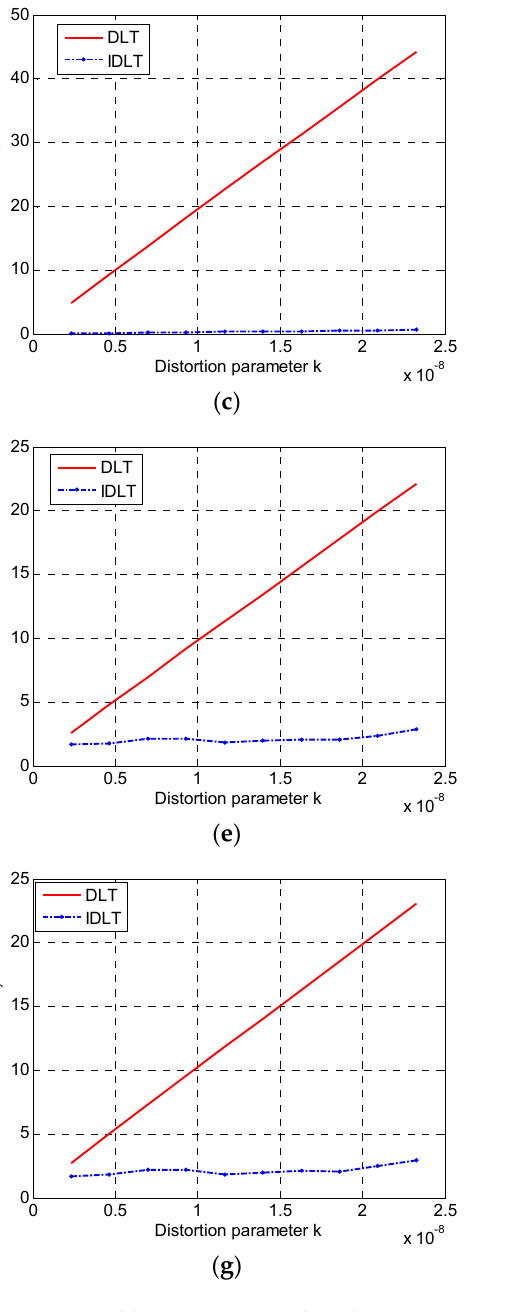
Figure 7. Calibration error analysis between DLT and IDLT with noise and distortion: ( a ) error of u 0 ; ( b ) error of v 0 ; ( c ) error of t x ; ( d ) error of t y ; ( e ) error of a x ; ( f ) error of t z based on a x ; ( g ) error of a y ; ( h ) error of t z based on a y